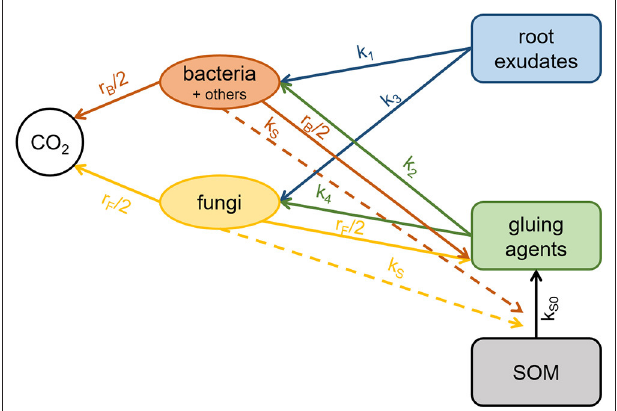
FIGURE 1 | Scheme of the biochemical cycle underlying the mathematical model, where solid arrows represent C transfer rates and dashed arrows catalytic